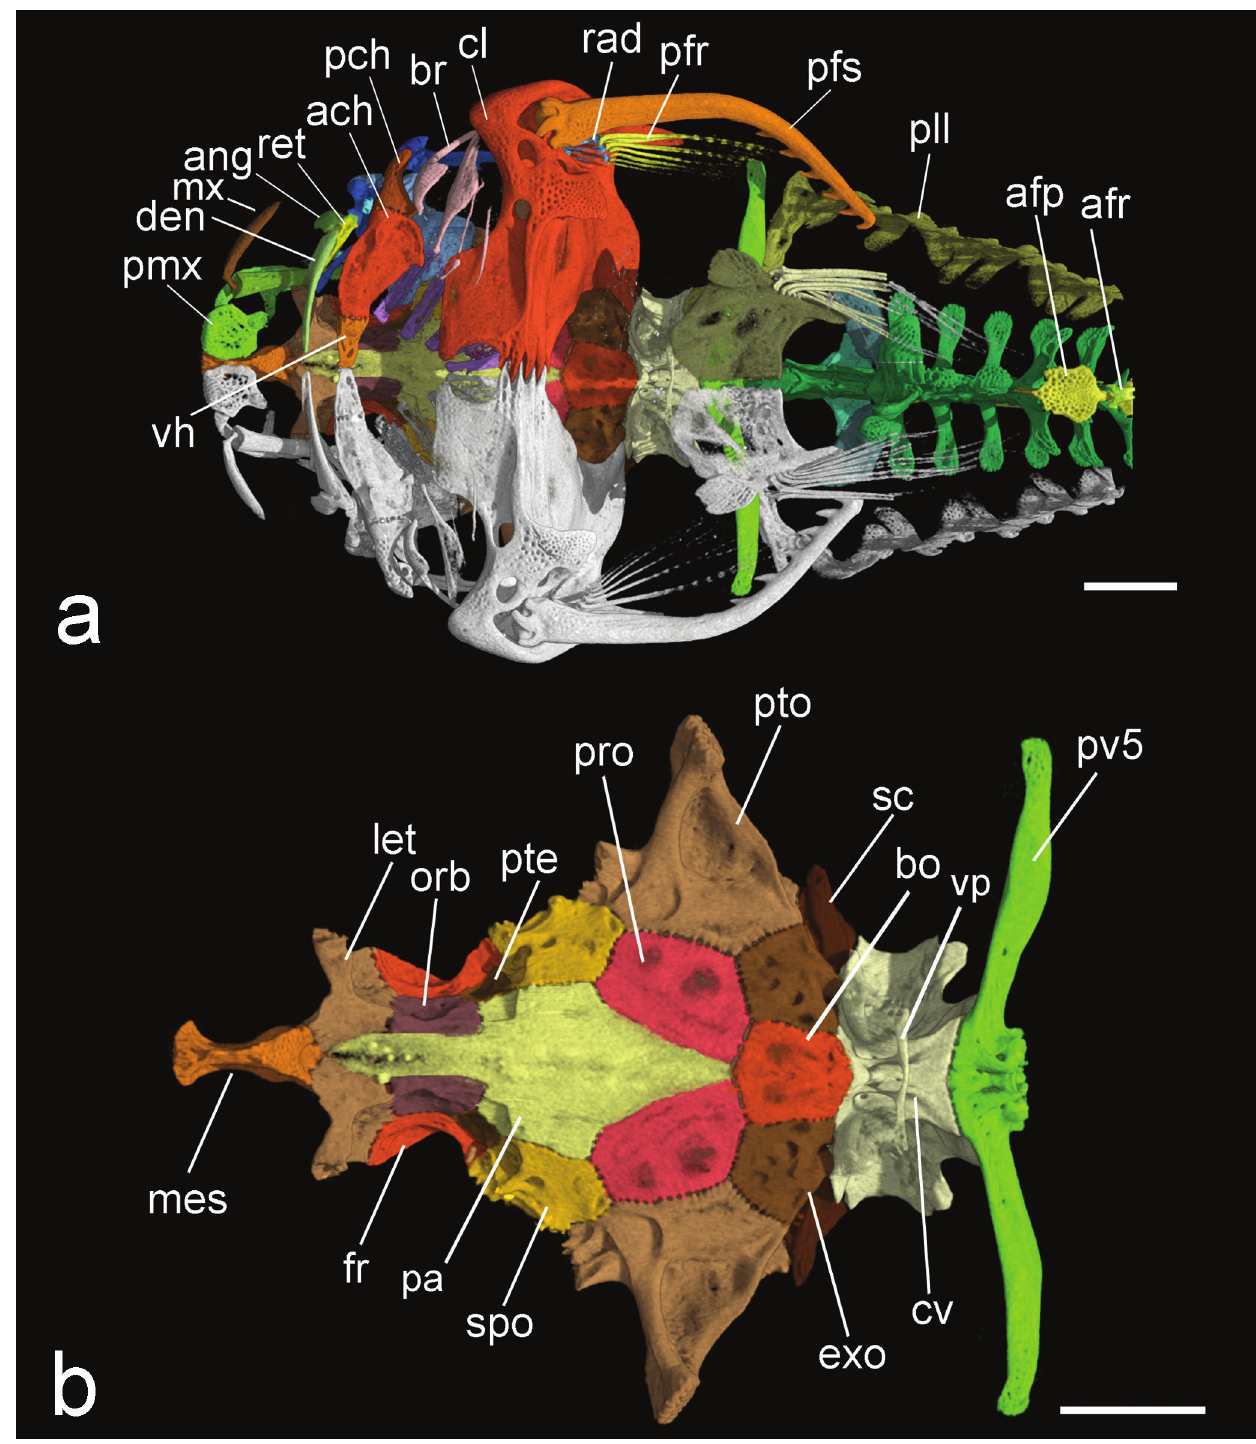
Fig. 4. HRXCT model of skull and anterior body of Hoplomyzon cardosoi , MCNG 375, holotype, 18.5 mm SL. a. Ventral view of skull and anterior body. b. Ventral view of neurocranium and first vertebrae. ang: anguloarticular; ach: anterior ceratohyal; afp: anal-fin pterygiophore; afr: anal-fin ray; bo: basioccipital; br: branchiostegal rays; cl: cleithrum; co: scapulocoracoid; cv: complex vertebrae; den: dentary; exo: exoccipital; fr: frontal; let: lateral ethmoid; mes: mesethmoid; met: metapterygoid; mx: maxilla; orb: orbitosphenoid; pa: parasphenoid; pch: posterior ceratohyal; pfr: pectoral-fin rays; pmx: premaxilla; po: preopercle; pro: prootic; ps: pectoral-fin spine; pte: pterosphenoid; pto: pterotic; pv5: parapophyses of vertebra 5; rad: pectoral-fin radial; ret: retroarticular; sc: postemporo-supracleithrum; soc: parietal-supraoccipital; spo: sphenotic; tr: tripus; vh: ventral hypohyal; vp: ventral process of complex vertebrae. Scale bars = 1